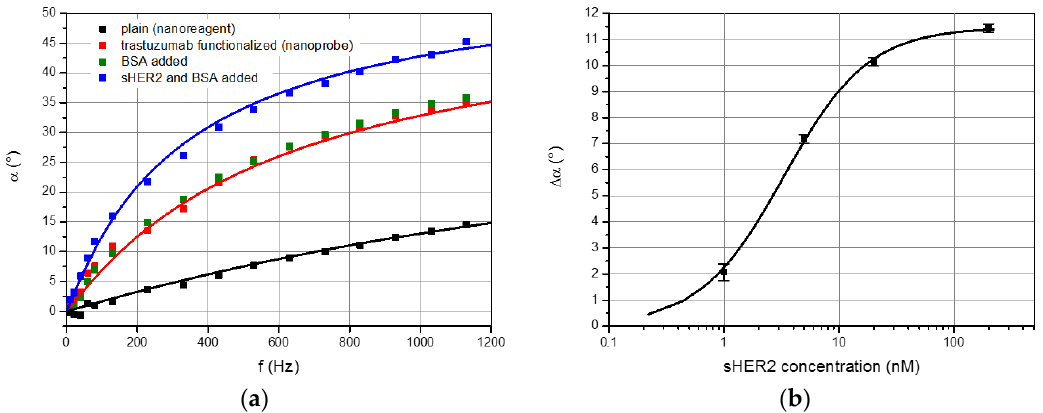
Figure 21. Measured phase lag spectra and assay results for the detection of the sHER2 target protein: ( a ) Phase lag α in dependence of the frequency f of the applied external magnetic field of 5 mT strength. Plain nanorods without antibody functionalization (black), trastuzumab antibody functionalized nanoprobes (red), and nanoprobes with fully assembled target protein shell (blue) are compared. Here, the markers correspond to measured data points, while the lines originate from the fitting procedure. BSA protein is added to the nanoprobes to ensure the absence of unspecific binding (green markers); ( b ) Assay results for the sHER2 protein in spiked buffer samples. The markers denote measured phase lag differences, while the line represents a logistic fit function applied for determining the assay sensitivity. The external rotating magnetic field was applied at an amplitude of 10 mT at a frequency of 1000 Hz. Reprinted with permission from [291]. Copyright 2016, American Chemical Society.